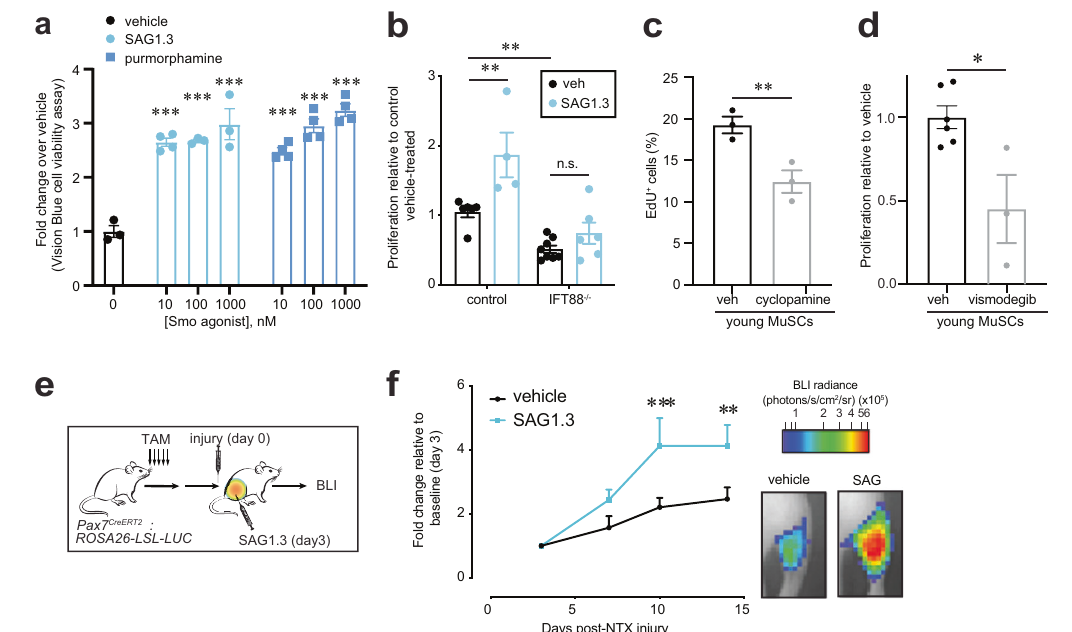
Fig. 3 SMO agonist treatment promotes MuSC expansion. a SMO agonists SAG1.3 and purmophamine promote MuSC proliferation in a dose-dependent manner ( n = 3 – 4 biological replicates per condition, isolated from independent mice and each performed in 3 technical replicates). b Proliferation of control or IFT88 − / − MuSCs treated with vehicle (veh) or SMO agonist SAG1.3 (50nM), shown as fold change normalized to control vehicle treated ( n = 5 control veh, 4 control SAG1.3, 8 IFT88 − / − veh, 6 IFT88 − / − SAG1.3). c Percentage of EdU + vehicle or 5 µ M cyclopamine (SMO antagonist) treated MuSCs ( n = 3 mice per condition). d Vismodegib (100nM, SMO antagonist) inhibits MuSC proliferation as determined by Vision Blue assay ( n = 7 veh and 3 vismodegib treated). e , f Expansion of endogenous MuSCs in Pax7CreERT2;Rosa26-LSL-Luc mice treated with tamoxifen (TAM) to label resting MuSCs and assayed by BLI post- notexin injury. e Experimental scheme. f Left: BLI ( n = 8 mice per condition, individual data points in Supplementary Fig. 3a). Right: Representative BLI image. * P <0.05, ** P <0.01, *** P <0.001. Mann – Whitney test ( c , d ). ANOVA test with Fisher ’ s LSD for multiple comparisons ( a , b ). Signi fi cance relative to vehicle (0nM) ( a ); 2 way ANOVA test with Fisher ’ s LSD for multiple comparisons per time point ( f ). Source data are provided as a Source Data fi le. Means +